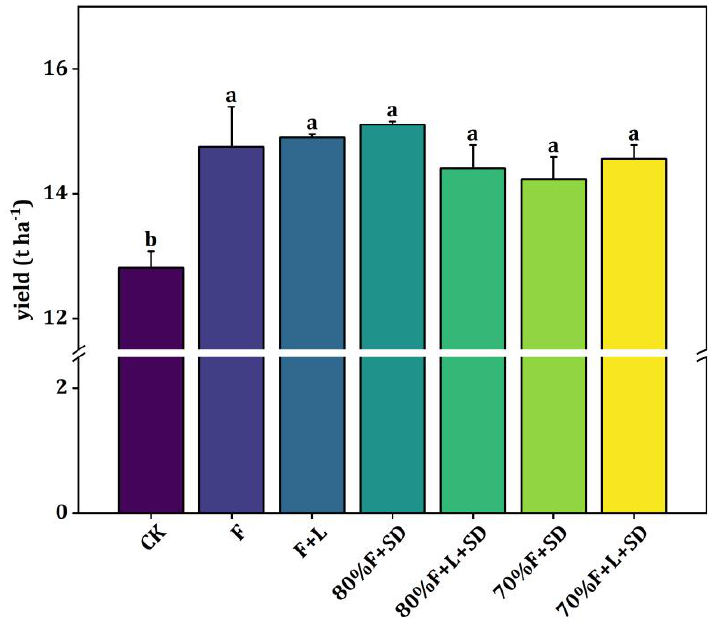
Figure 4. Effect of LOM on yield of A. selengensis . All values are means of three replicates with error bars indicating the standard error. Different lowercase letters show significant variability among treatments ( p < 0.05).